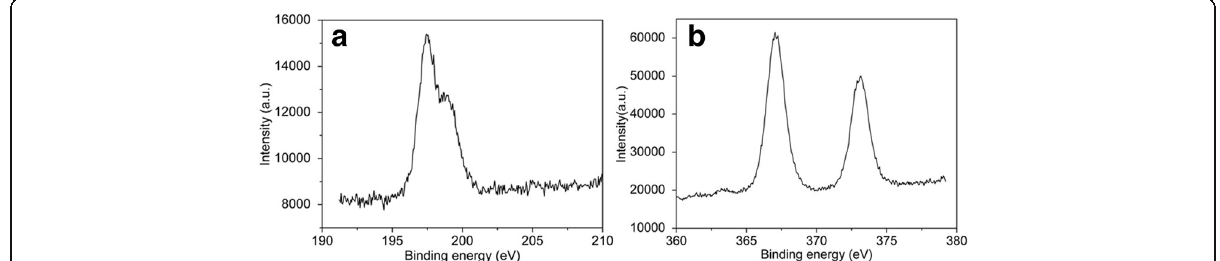
Fig. 4 XPS spectra of a Cl 2p region and b Ag 3d region of Ag@AgCl core – shell nanowires synthesized with the mole ratio of Ag nanowires:FeCl 3 =